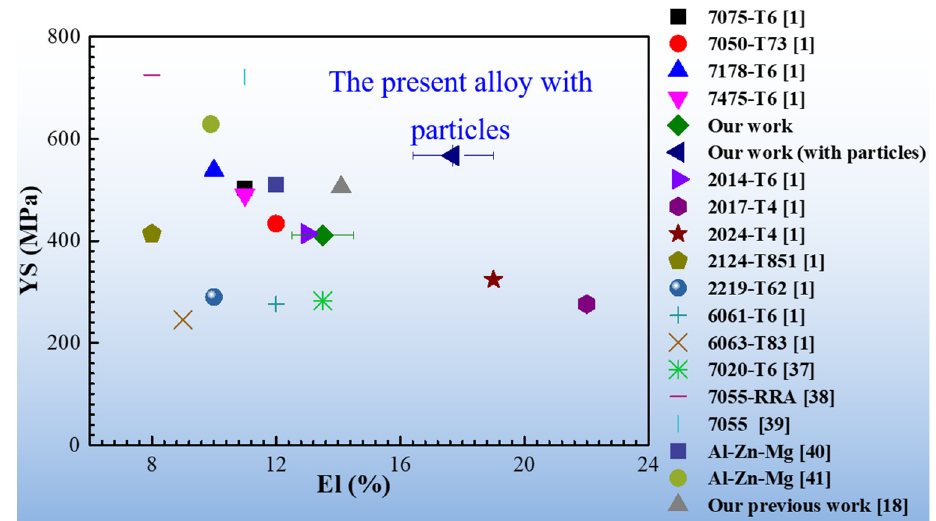
Figure 4. Yield strength versus elongation to failure.